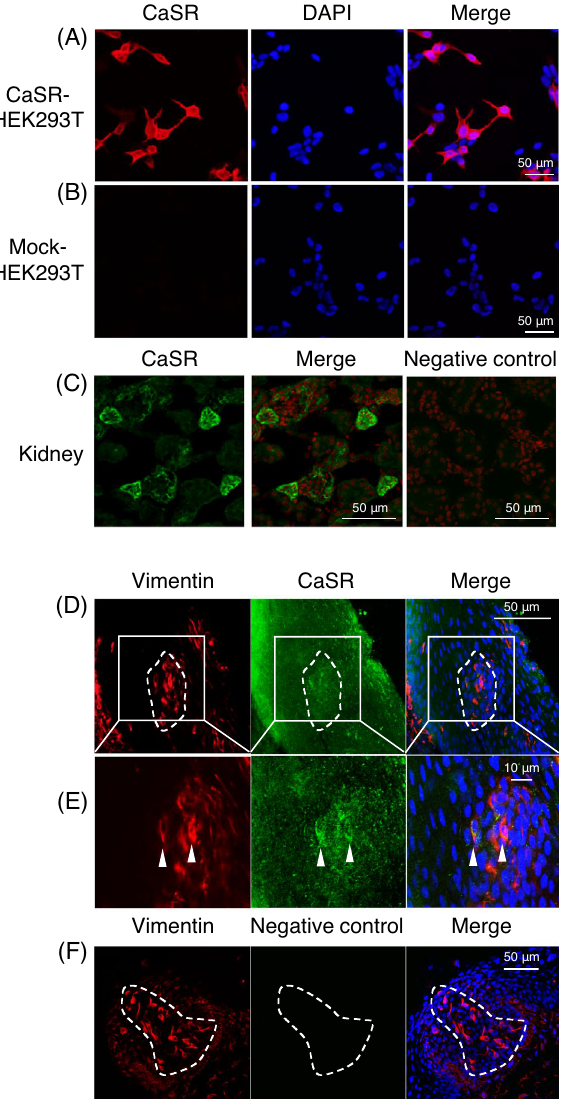
Figure 2. ( A ) HEK293T cells transiently transfected with c CaSR /pcDNA5/FRT were immunostained by the cCaSR antiserum generated herein (red). Nuclei were stained with DAPI (blue). ( B ) HEK293T cells transiently transfected with empty vector pcDNA5/FRT (mock) were not labeled by the antiserum. Nuclei were stained with DAPI (blue). ( C ) Expression of CaSR (green) in the kidney in 9-day-old chicks. Ten similar images of kidney were obtained from two chicks. Nuclei were stained with DAPI (red). ( D, E ) Expression of vimentin (red) and CaSR (green) in the taste buds of the base of oral cavity in 7-day-old chicks. Four similar images of the base of oral cavity were obtained from two chicks. One representative image is shown. White dots outline the taste buds labeled by vimentin, the molecular marker for the taste buds of chickens 25 . Nuclei were stained with DAPI (blue). ( E ) shows a magnified image of ( D ). Arrowheads indicate taste cells immunostained by both vimentin and CaSR. ( F ) In the negative control, the antiserum for CaSR was omitted. Nuclei were stained with DAPI